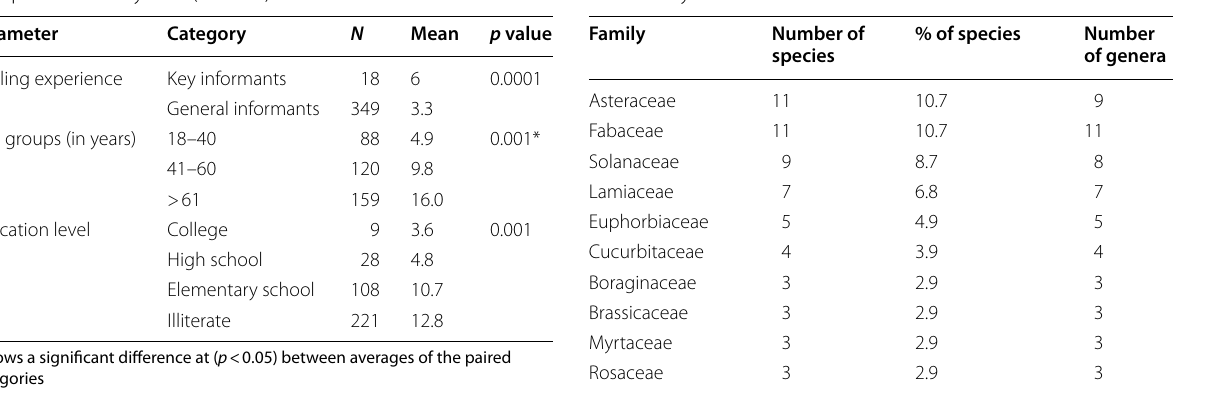
Table 2 Number of medicinal plants and genera belonging to